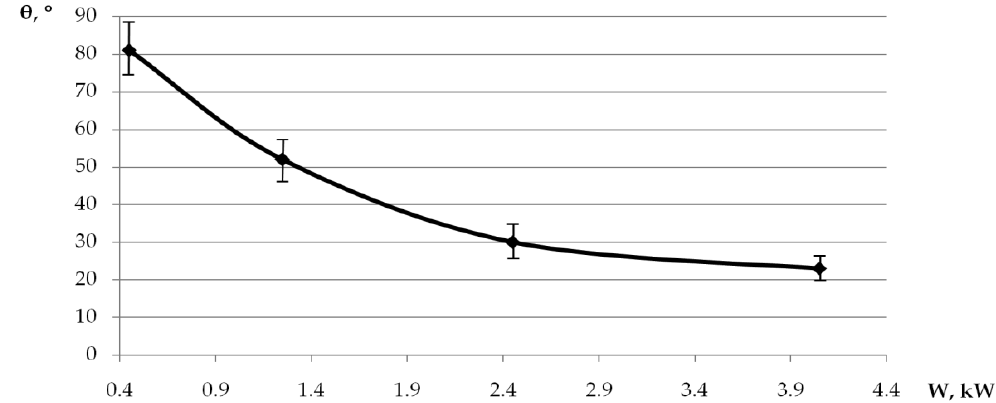
Figure 8. Influence of RF plasma treatment power on the marginal wetting angle of wood.